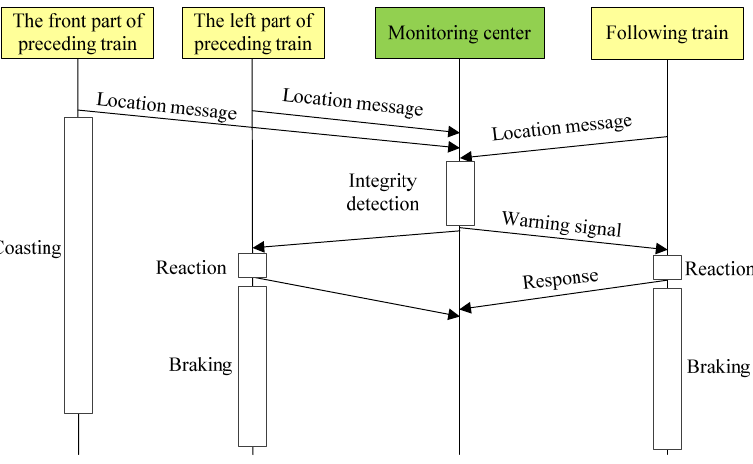
Figure 2. Timeline diagram of a train integrity detection under potential collision risk.